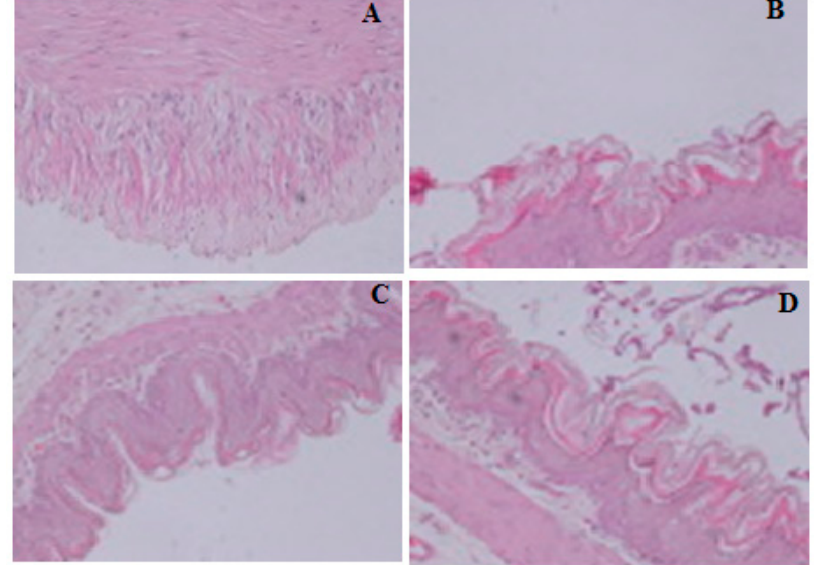
Figure 3. ( A ) Gastric section showing intact gastric mucosa of control rats. ( B ) Gastric section showing gastric mucosal ulceration consisting of necrosis, cellular debris neutrophils and degenerated epithelial cells of ethanol treated rats. ( C ) Gastric section showing focal mucosal ulceration consisting of predominantly neutrophils and degenerated epithelial cells of compound S3 (25.6 mg/kg) and ethanol treated rats. ( D ) Gastric section showing intense mucosal ulceration consisting of necrosis, cellular debris, neutrophils and degenerated epithelial cells of indomethacin (25 mg/kg) and ethanol treated rats.